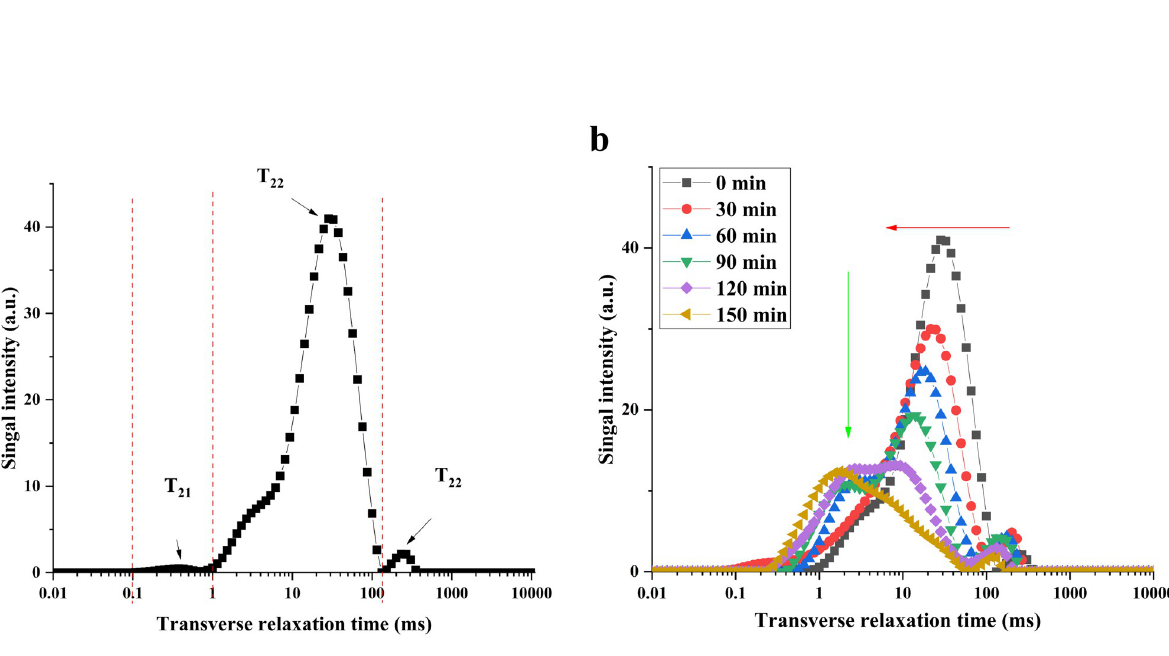
PLOS ONE | https://doi.org/10.1371/journal.pone.0265383 March 14,